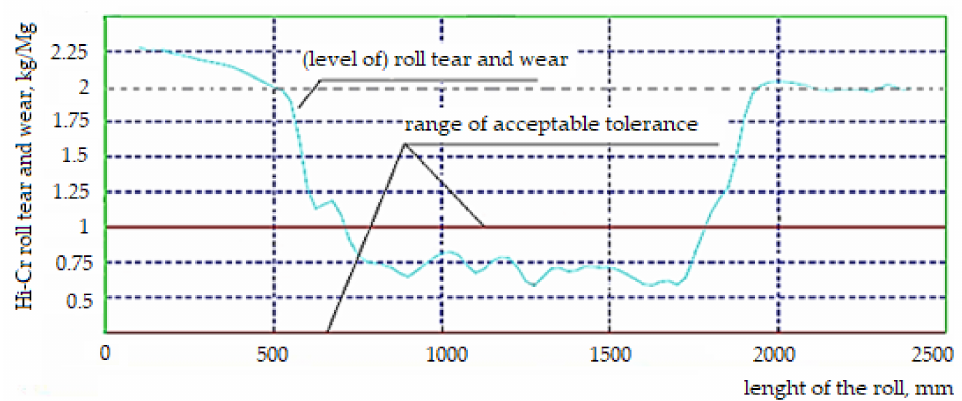
Figure 2. Diagram of high chromium cast rolls local tear and wear levels. Source: own, based on